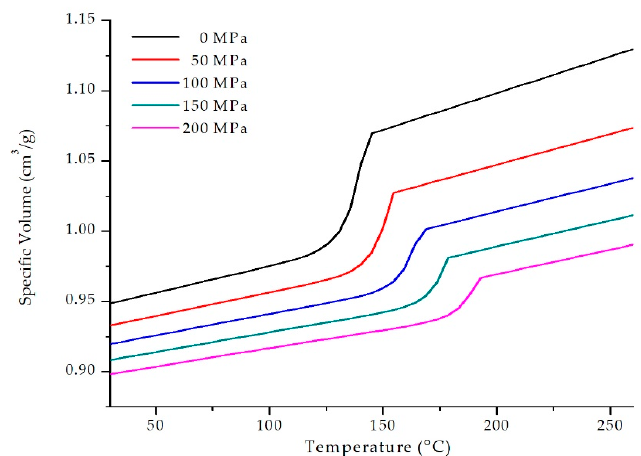
Figure 1. Pressure-Volume-Temperature data of the copolymer polypropylene used in this research.